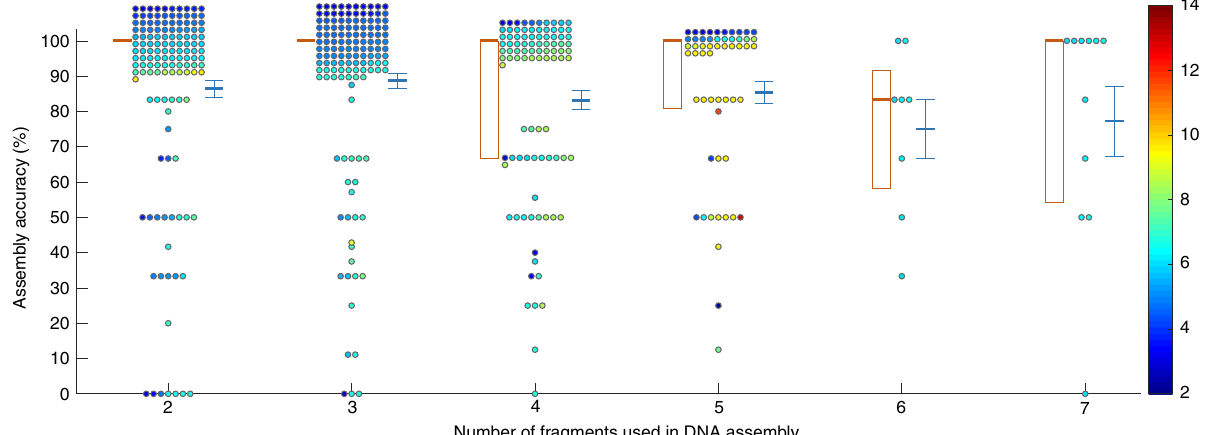
Fig. 3 Statistics of 436 plasmids constructed under GTS. Assembly accuracy was percentage of colonies that have the correct plasmid. Each circle presents one plasmid construction. Face color of each circle indicates length of the plasmid (the color bar is provided, unit: kb). Each thick orange horizontal bar presents median of accuracies of a group (plasmids constructed from the same number of fragments were included in one group). Each orange box indicates 1st and 3rd quantiles of accuracies of a group. Each thick blue horizontal bar and the related error bar indicate mean and standard error of accuracies of a group respectively. For illustration purpose, circles with the same accuracy and fragment number are distributed around accurate values of accuracy and fragment number on the plot